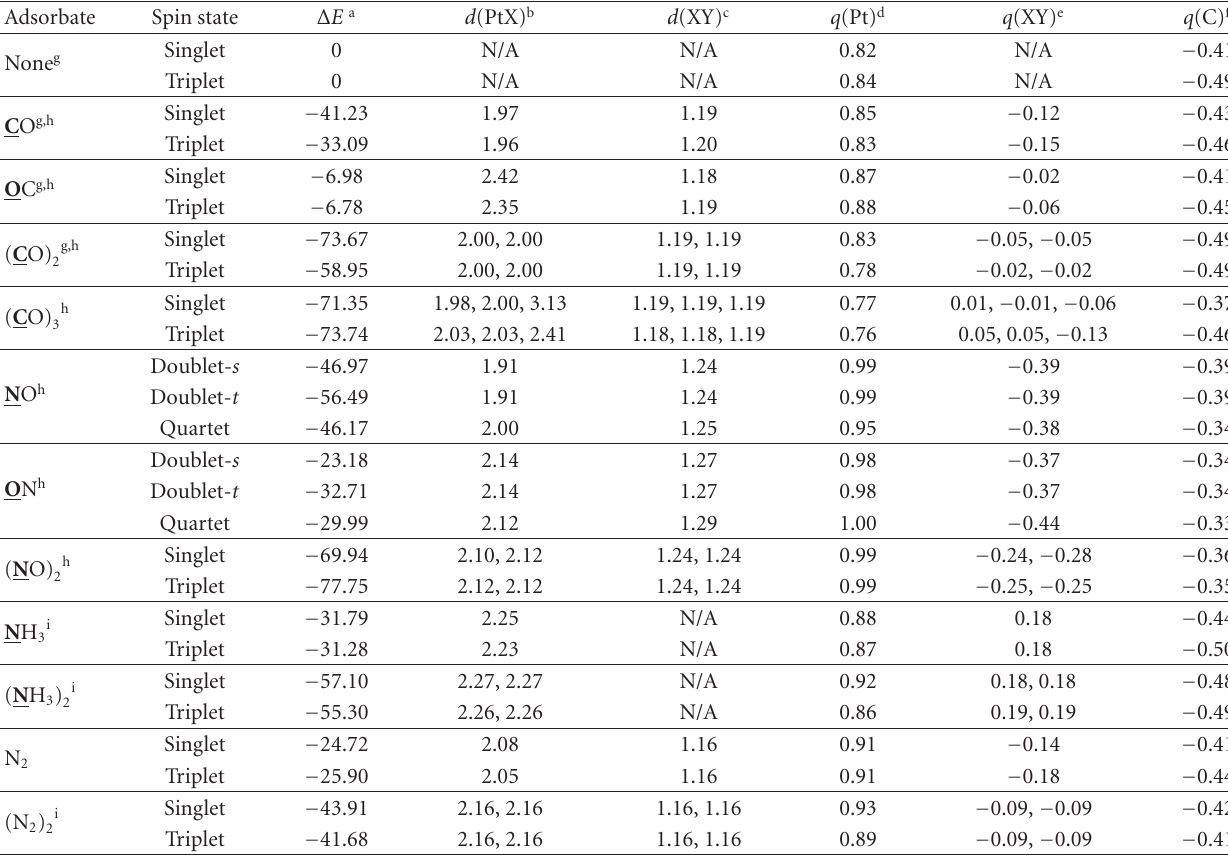
Table 3: Binding energy and geometrical data for nanotube-adsorbate complexes C 69 H 20 Pt(XY) with end-on binding motif [114].